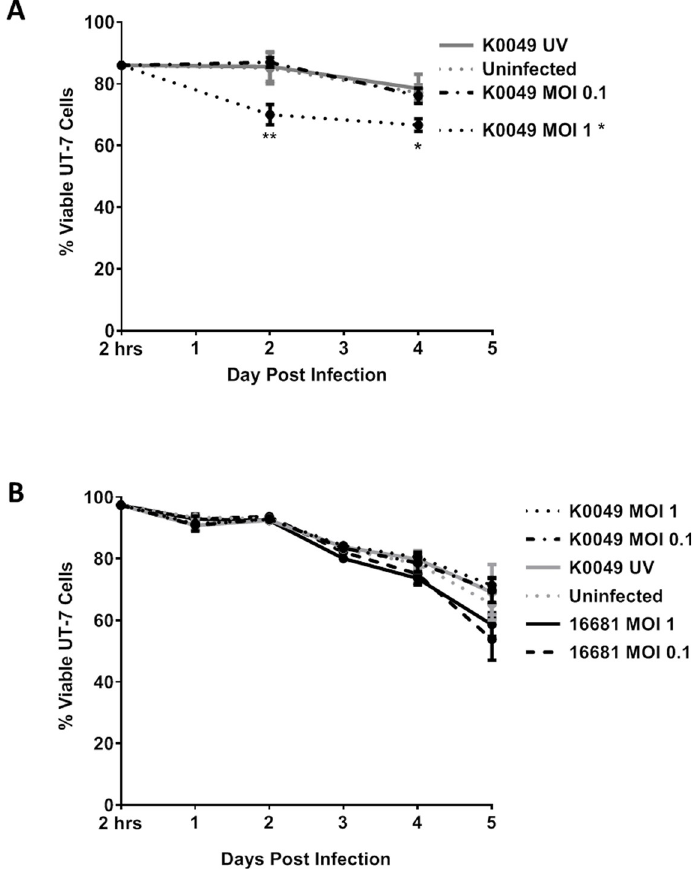
Fig 7. Dengue virus infection does not affect UT-7 cell viability. Viability of UT-7 cells infected with DENV was assessed every other day via trypan blue (A) or daily via flow cytometry (B). Data from three independent experiments are represented as the mean percentage of viable UT-7 cells. Error bars are 1 SEM. Statistical significance was determined using a two-way ANOVA and multiple comparisons t-test (with Holm-Sidak correction). Statistical significance next to the virus strain name indicates that that infection was significantly different from the uninfected control as assessed by two-way ANOVA. Significance at a specific timepoint indicates that the condition at that timepoint was significantly different from the uninfected control via t-test. � p < 0.05; �� p < 0.01; ��� p < 0.005; ���� p <